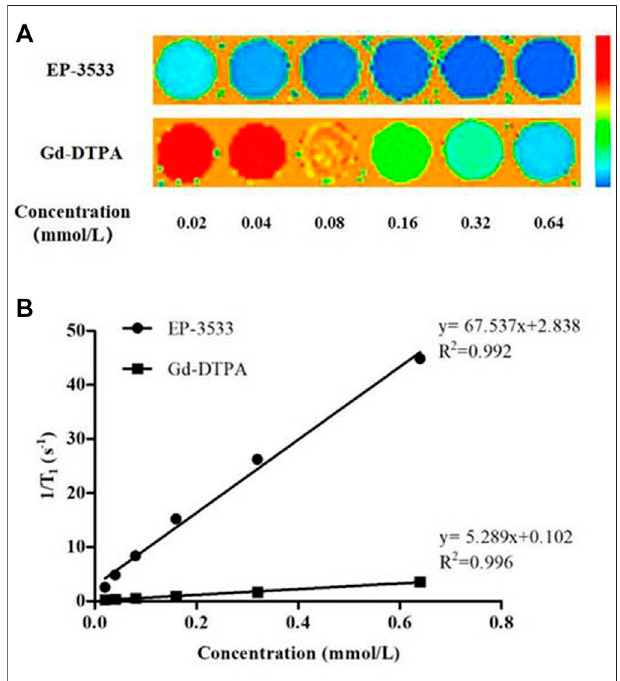
FIGURE 1 | The longitudinal relaxivity of EP-3533 and Gd-DTPA. T 1 maps (A) of EP-3533 and Gd-DPTA were obtained in aqueous solution at 25 ° C at 3.0-T fi eld strengths. The slopes of the linear fi tting equation (B) represents the relaxivities of the contrast